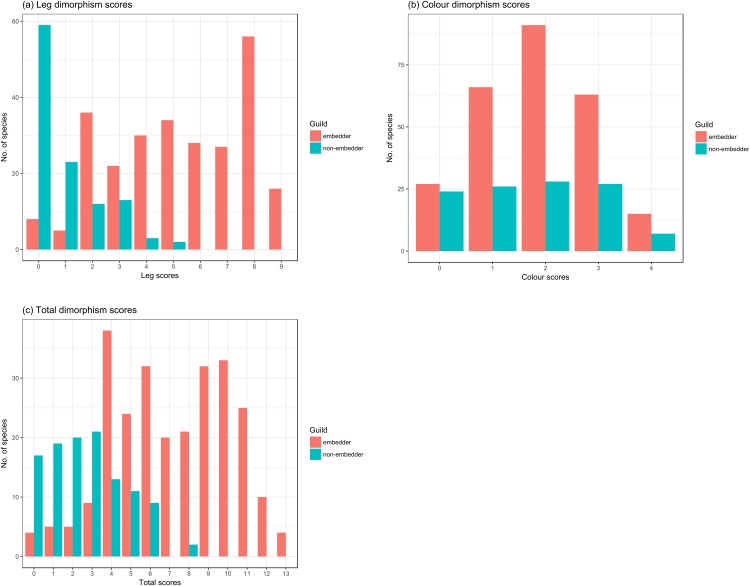
Counts of species from the two different feeding guilds for dimorphism scores for leg and colour.Counts of embedder and non-embedder species showing respective dimorphism scores for (A) leg, (B) colour, and (C) total score. High scores represent strongly sexually dimorphic species.